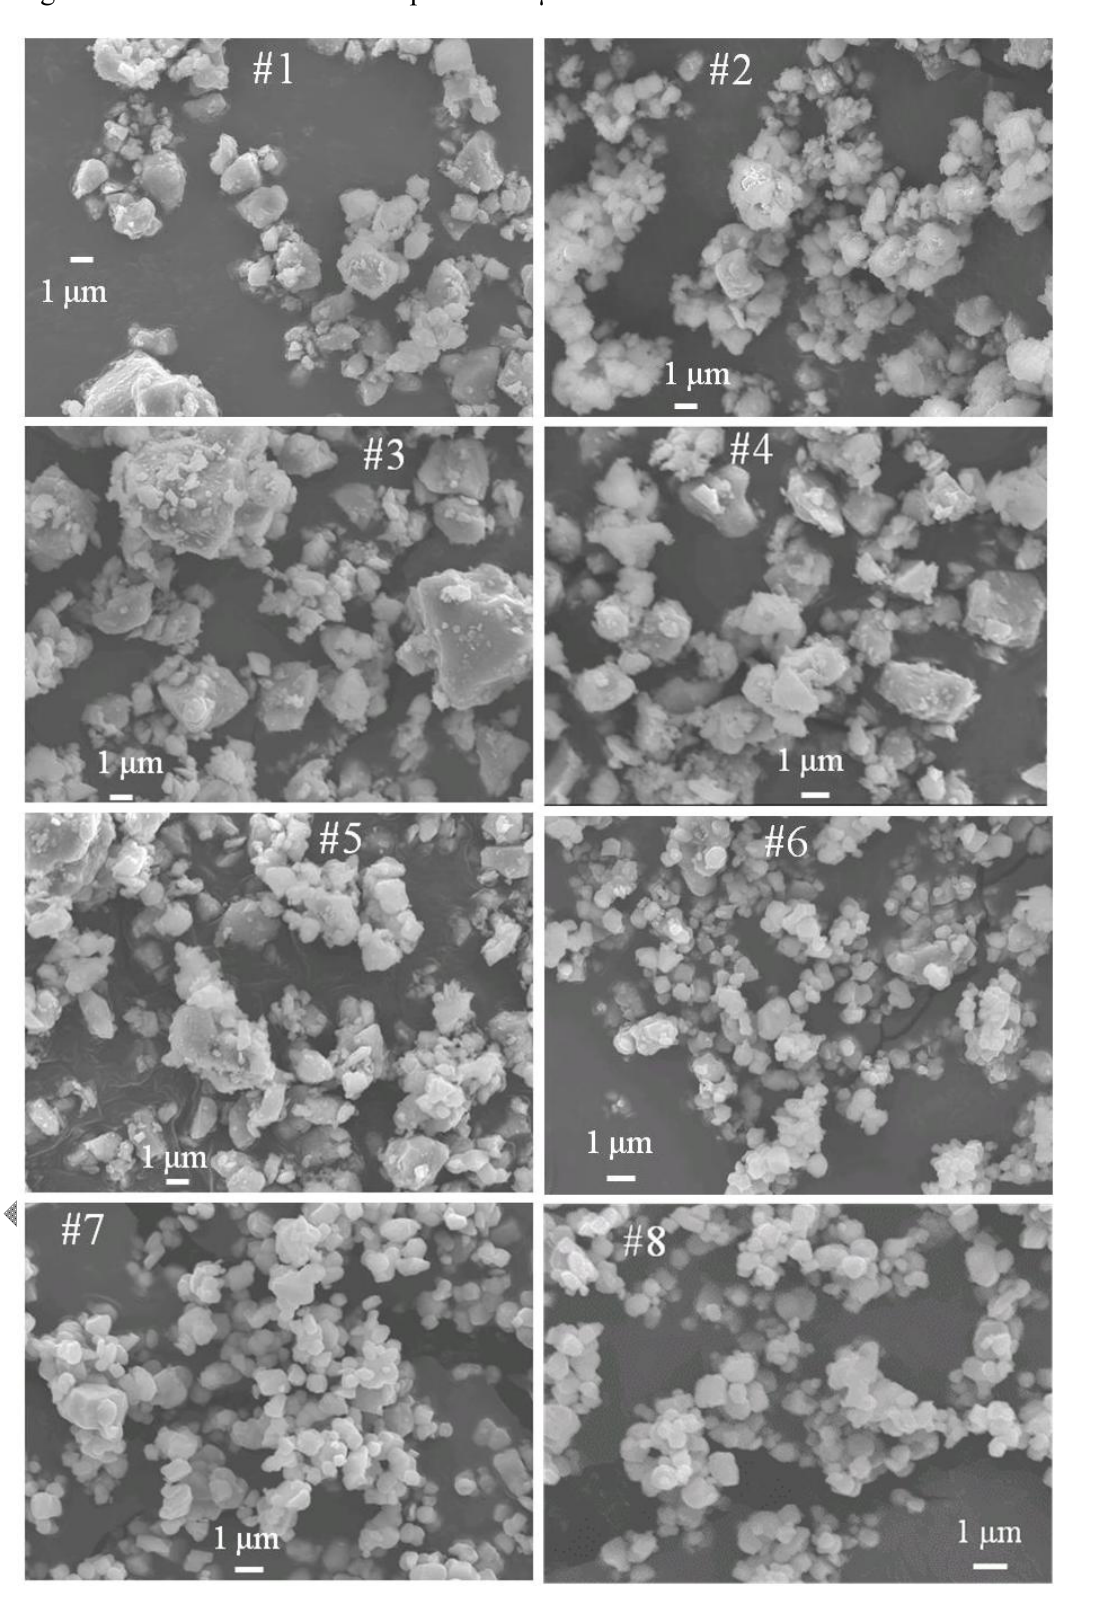
Figure 6. SEM images of synthesized materials. All images are taken at 5000 magnification and the scale bar represents 1